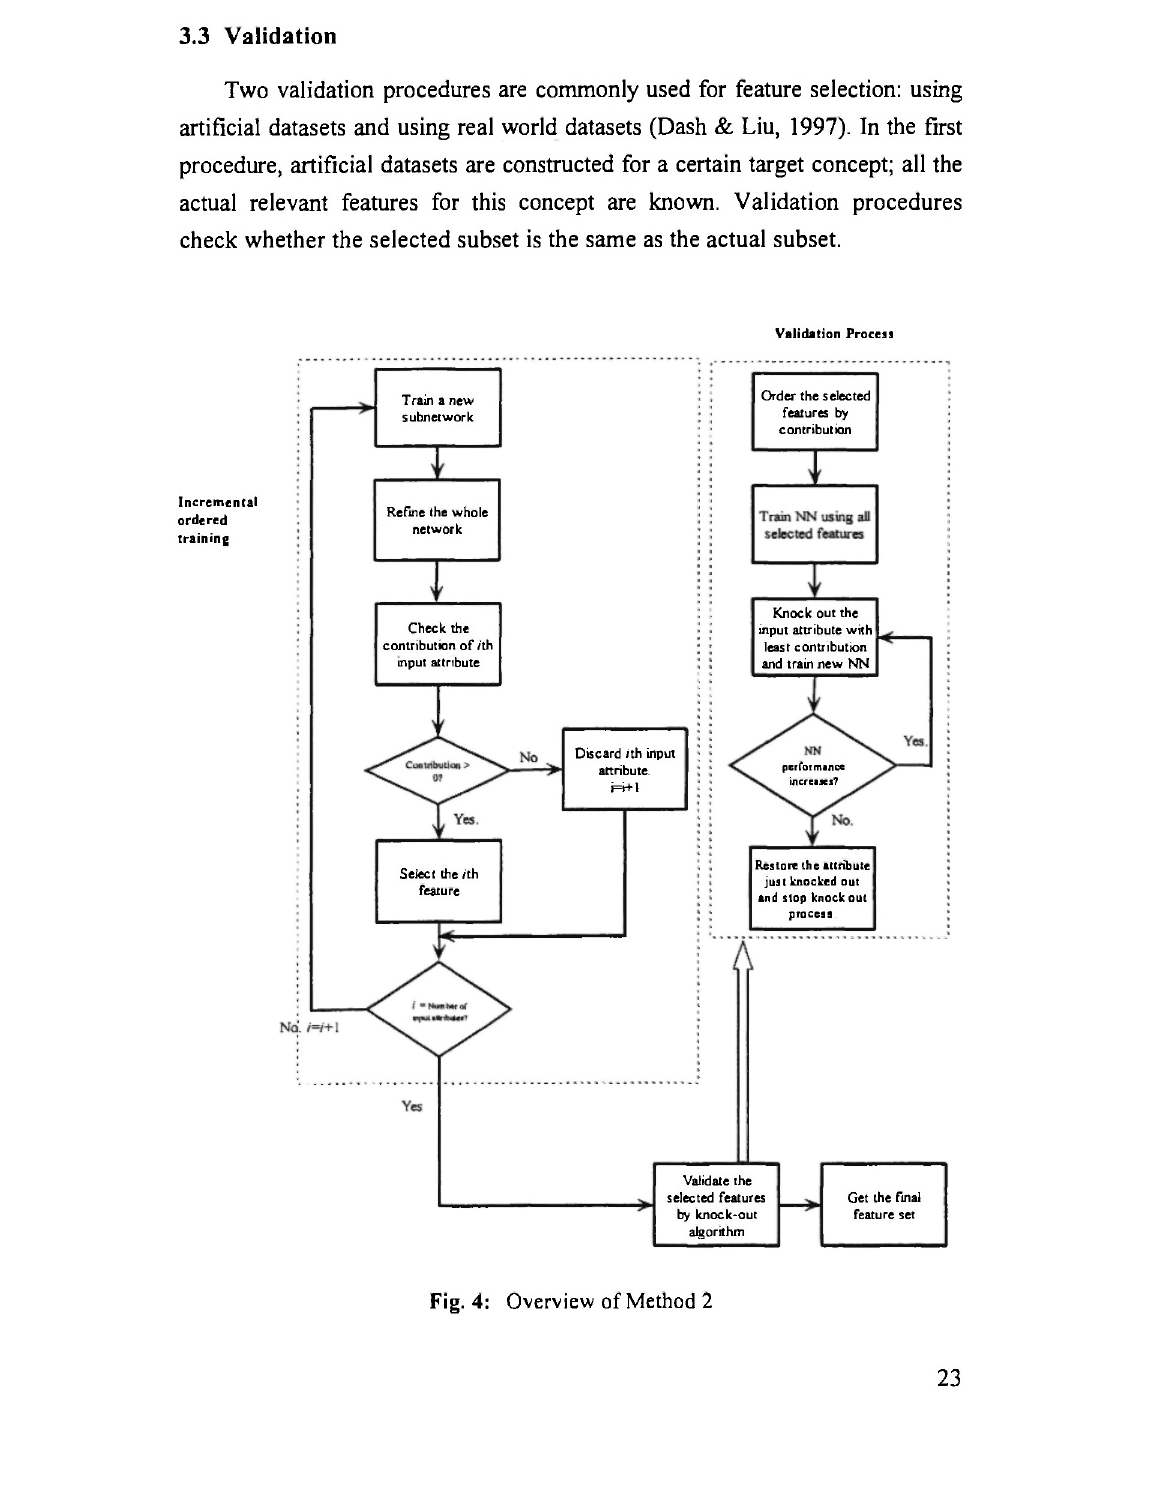
Fig. 4: Overview of Method